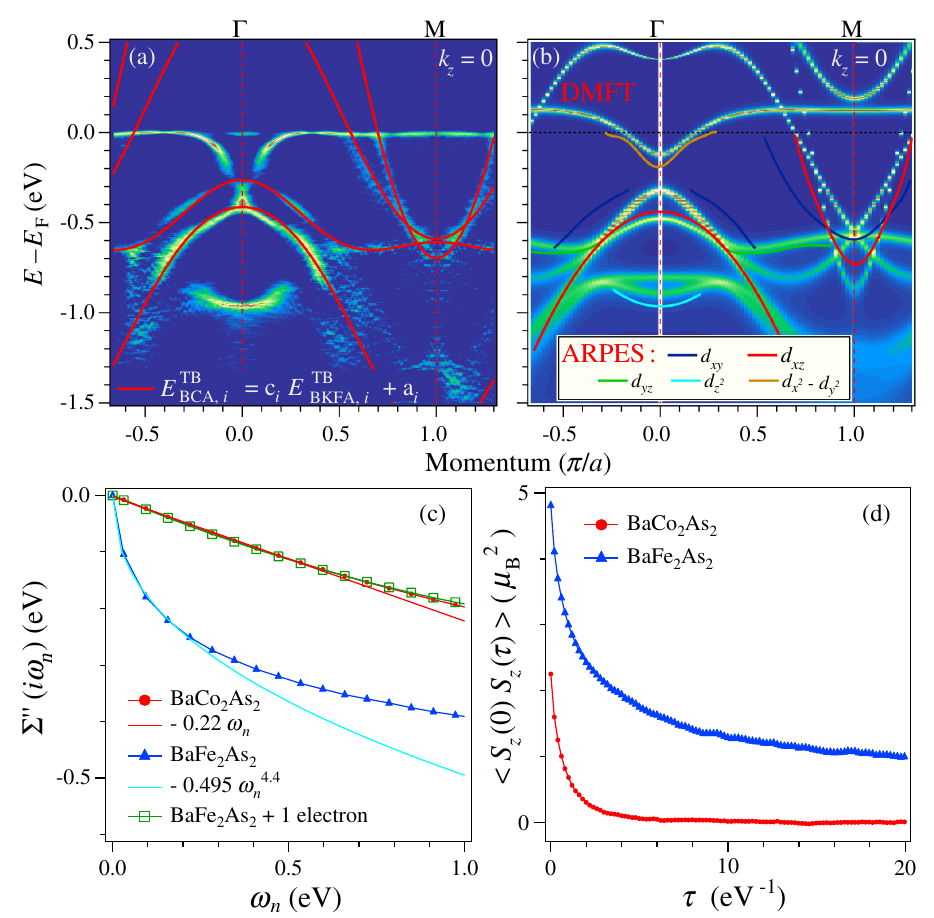
FIG. 4. (a) 2D curvature-intensity plot [17] along (cid:1) -M compared with a tight-binding-band fit (red lines). A direct correspondence between the tight-binding energy E TB BCA ;i of the i th band in BaCo 2 As 2 and the tight-binding energy E TB BKFA ;i of the i th band in K Fe As c a Ba 1 (cid:1) x x 2 2 is obtained after multiplying the latter band by a factor i and shifting it by a constant i . Except for a 470-meV rigid band shift, the bandwidth of the (cid:7) band is 4 times larger than in Ba 0 : 6 K 0 : 4 Fe 2 As 2 [18], in contrast to 2 times for all other bands. (b) LDA þ DMFT calculation of the band structure of BaCo 2 As 2 (120 K). The experimental bands are overlapped for comparison. (c) Imaginary part of the self-energy (120 K) as a function of the Matsubara frequency for BaCo 2 As 2 , BaFe 2 As 2 , and the hypothetical compound consisting of BaFe 2 As 2 with one additional electron per Fe atom. While a linear fit is performed for the BaCo 2 As 2 data, the As A! (cid:6) (cid:6) ¼ 0 : 44 . (d) DMFT calculation of the spin-spin correlations in BaFe 2 2 data are fit with a power-law n , for which we found